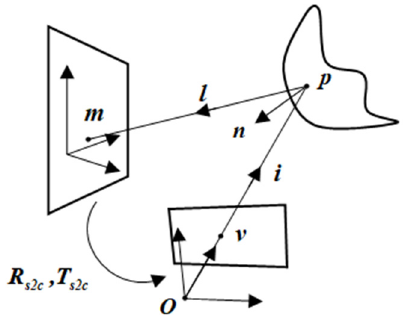
Figure 3. Principle of mirror surface measurement. A pinhole camera centered at O is observing a mirror surface point p that reflects a reference point m to an image point v . We refer to m and v as reflection correspondences. The reflected ray l is determined by m and p . We denote by i the incident ray for image point v and by n the normal at p . R s 2 c and T s 2 c denote the pose parameters between the reference plane and the